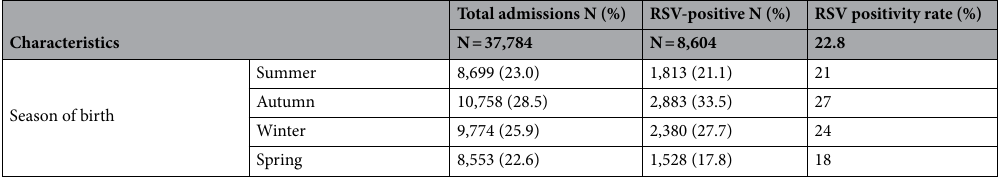
Table 1. Characteristics of laboratory-confirmed RSV-positive admissions used to generate the RSV prediction model, 2000–2012. RSV respiratory syncytial virus, ALRI acute lower respiratory infections, URTI upper respiratory tract infections, ICU intensive care unit. a Other infections include unspecified viral illness, Convulsions, fever and cough, and breathing abnormalities.